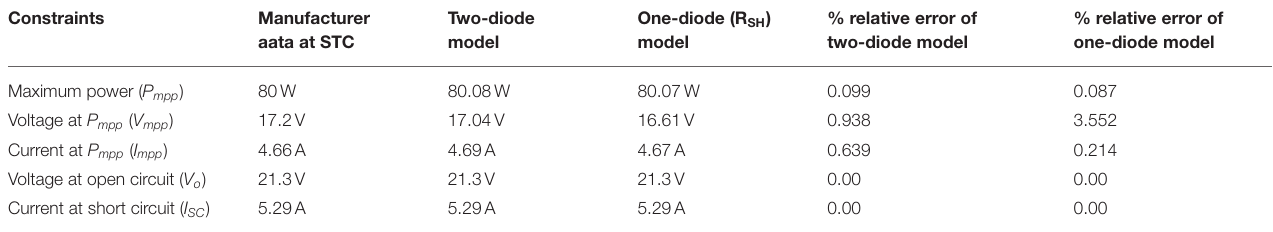
TABLE 4 | Comparison of estimated values at maximum power ( P mpp ) of the two-diode model and one-diode ( R SH ) model for a mono-crystalline (DS-A1-80) solar cell. Constraints